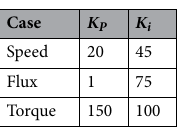
Table 1. Constant values of the PI